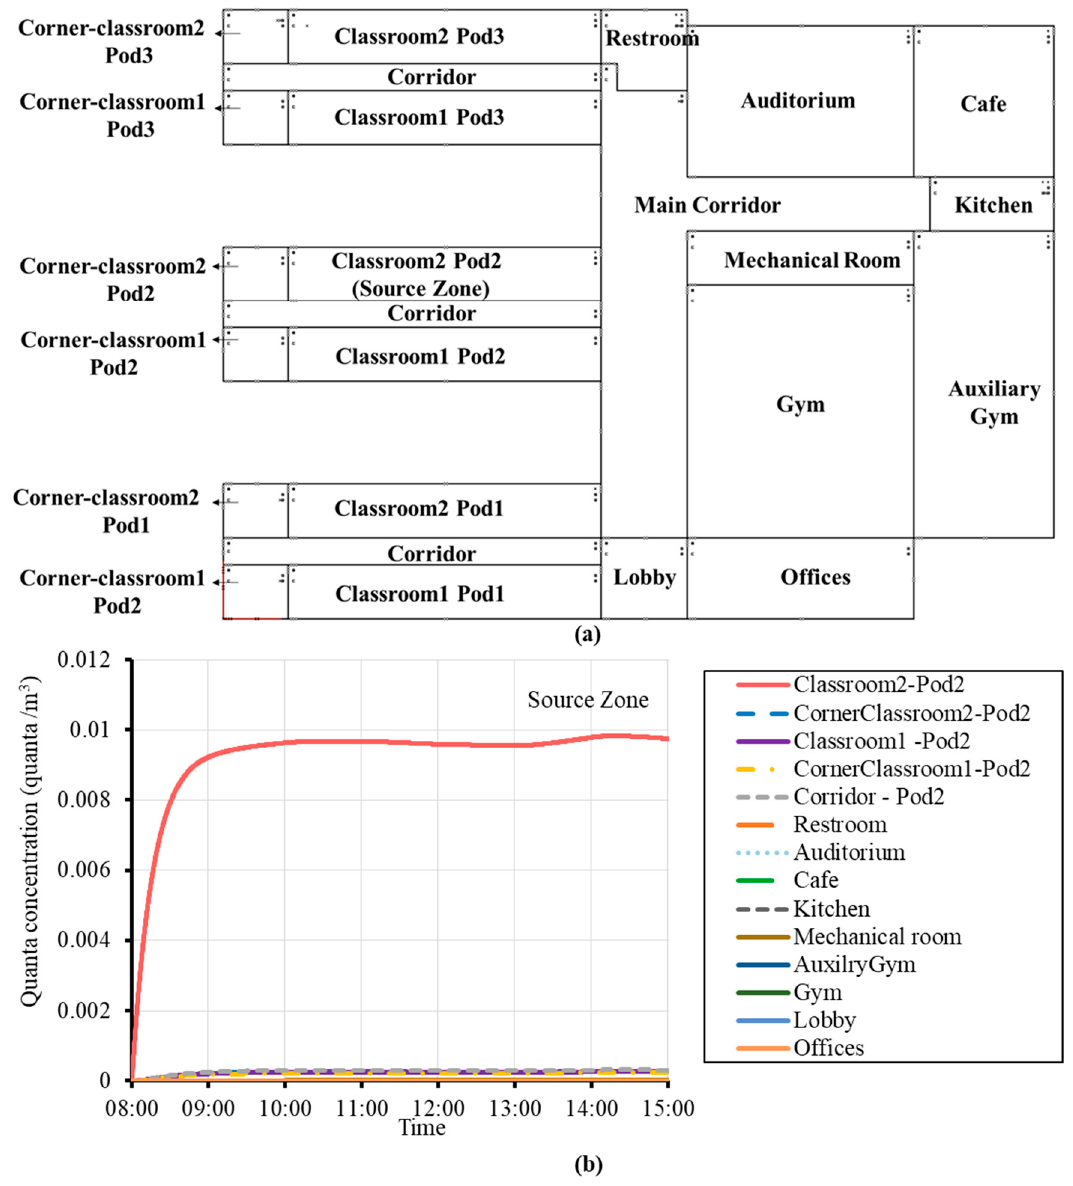
Figure 9. Secondary School ( a ) top-view diagram of the Secondary School 1 st floor and ( b ) quanta concentration as a function of time during a workday with the infector in the core zone on the first floor. Small icons in each room were contaminant generation source, deposition/deactivation items, and the supply/return of HVAC systems.